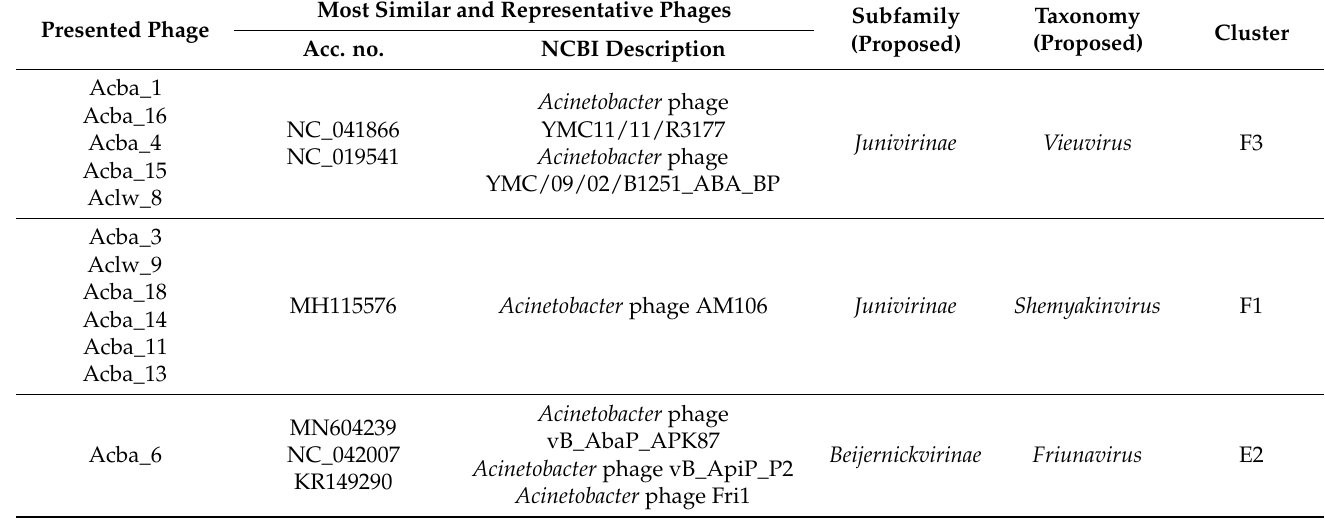
Table 7. Proposed taxonomy of the presented genomes on the basis of nucleotide sequence similarity and phylogenetic analysis of the major capsid protein in Acinetobacter phages. Presented classification, cluster designation, and representative phages are described in the cited work